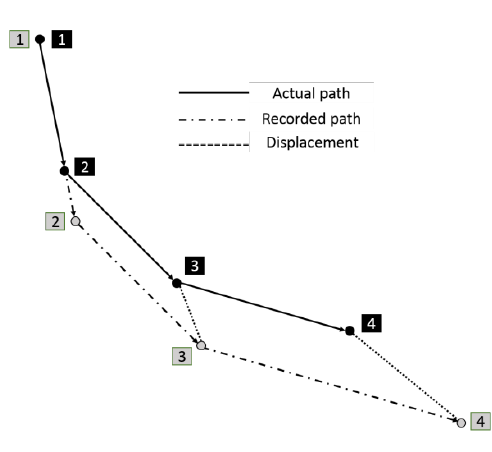
Figure 2. The error drift added to the system in every step.